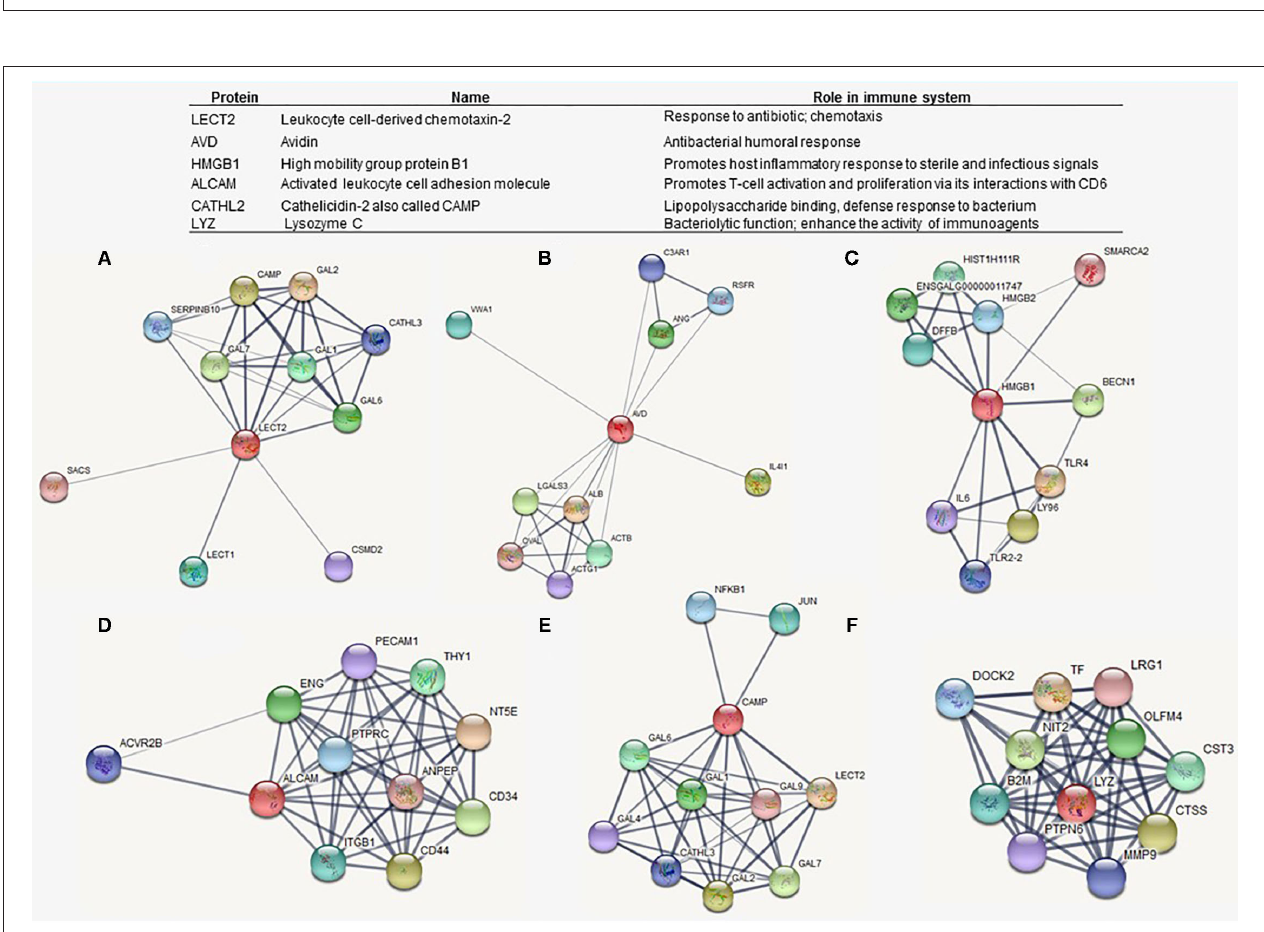
FIGURE 6 | Protein-protein interaction (PPI) network analyses of selected differentially expressed proteins associated with immunomodulatory functions. Red nodes denote the selected immune-related protein, and edges show the biological relationship between nodes. (A) Leukocyte cell-derived chemotaxin-2 (LECT2). (B) Avidin (AVD). (C) High mobility group protein B1 (HMGB1). (D) Activated leukocyte cell adhesion molecule (ALCAM). (E) Cathelicidin-2 also (CAMP). (F) Lysozyme C (LYZ).